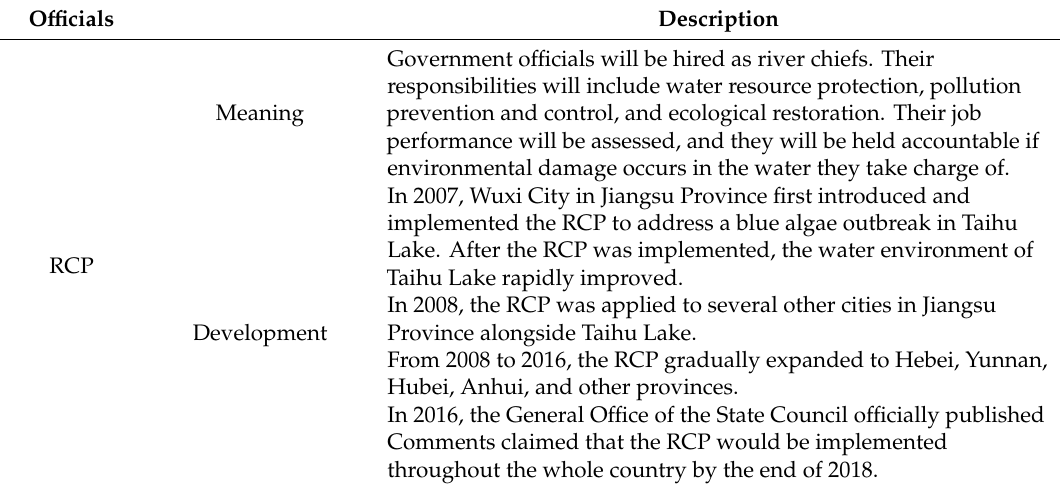
Table A5. O ffi cials and